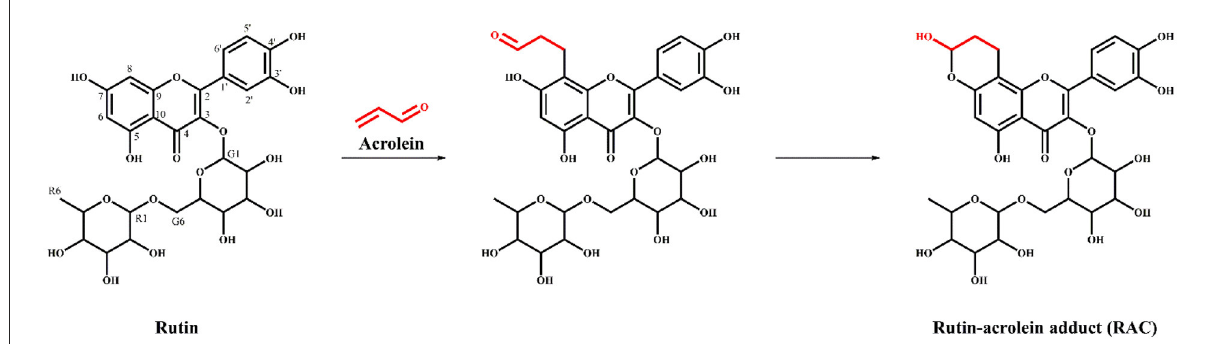
FIGURE4 The proposed reaction mechanism of acrolein and rutin to form the hemiacetal adduct RAC.